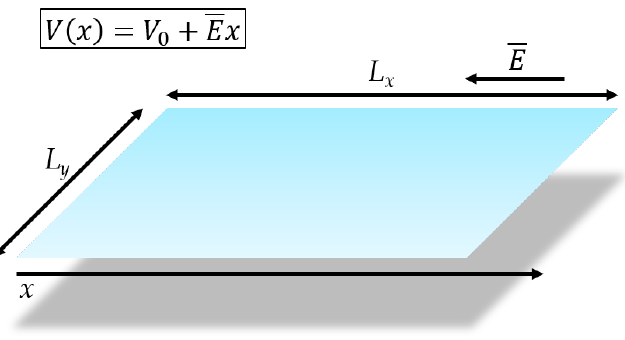
Figure 2. 2-D schematic representation of the